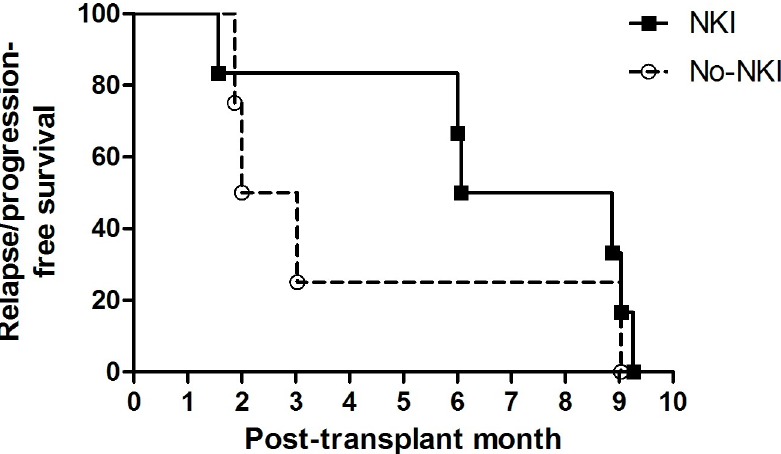
Fig 4. Kaplan-Meier curves in the patients with relapse/progression. The median time to relapse/progression in the current cohort was 7.5 months post-transplant, and that in the reference cohort who underwent haplo-SCT without NKI was 2.5 months